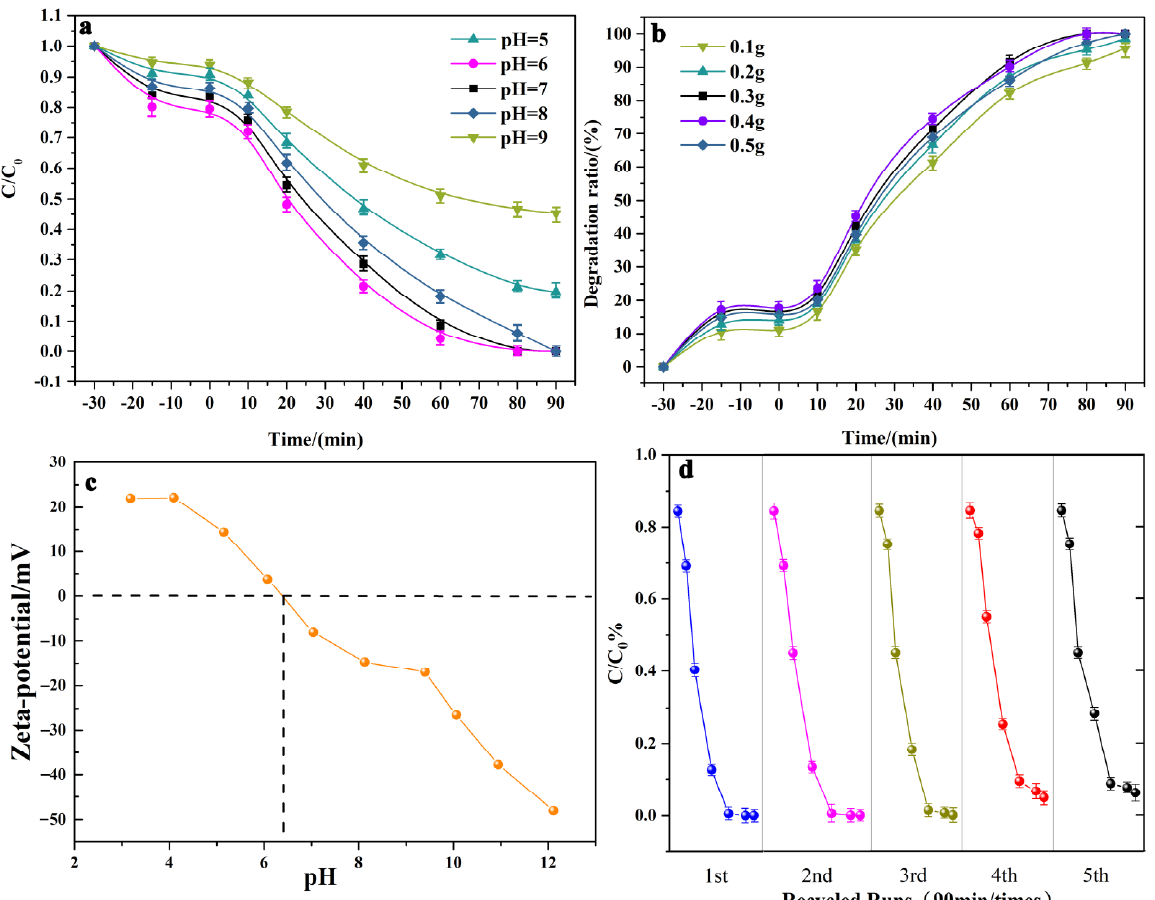
Figure 8. Degradation effect of 1:8 Bi 2 WO 6 /Bi 2 O 3 under different pH values and catalyst dosage ( a , b ); zeta potential and cycling stability of 1:8 Bi 2 WO 6 /Bi 2 O 3 ( c , d ).